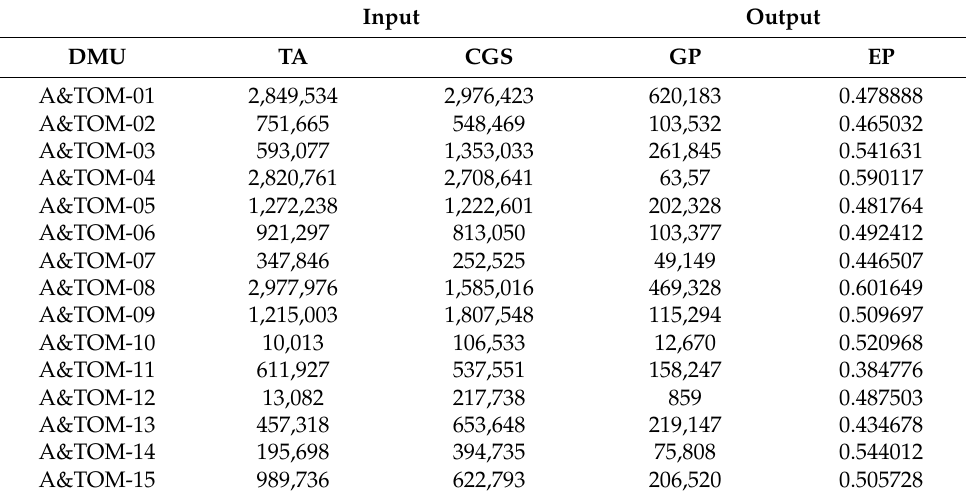
Table 16. DEA model’s inputs and outputs.